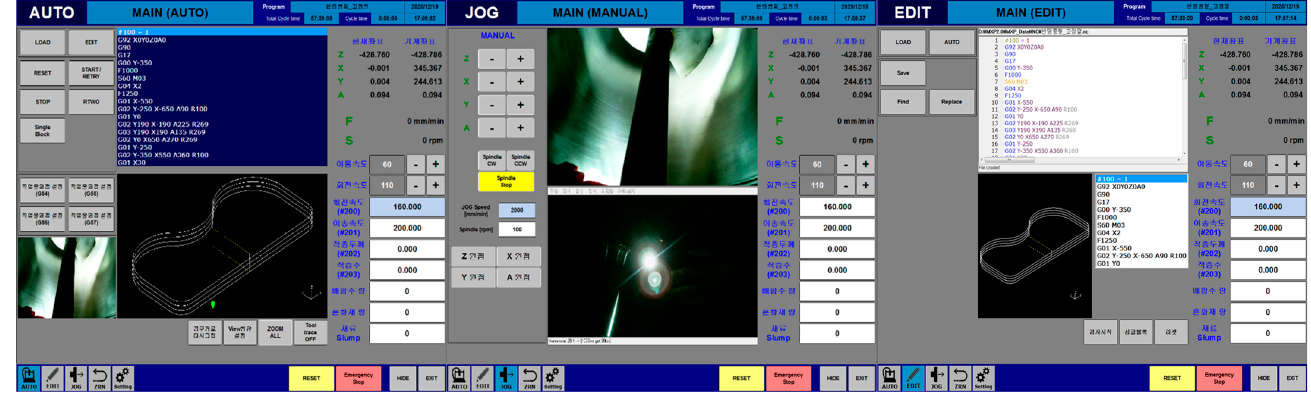
Figure 7. Control module of 3DCP system.